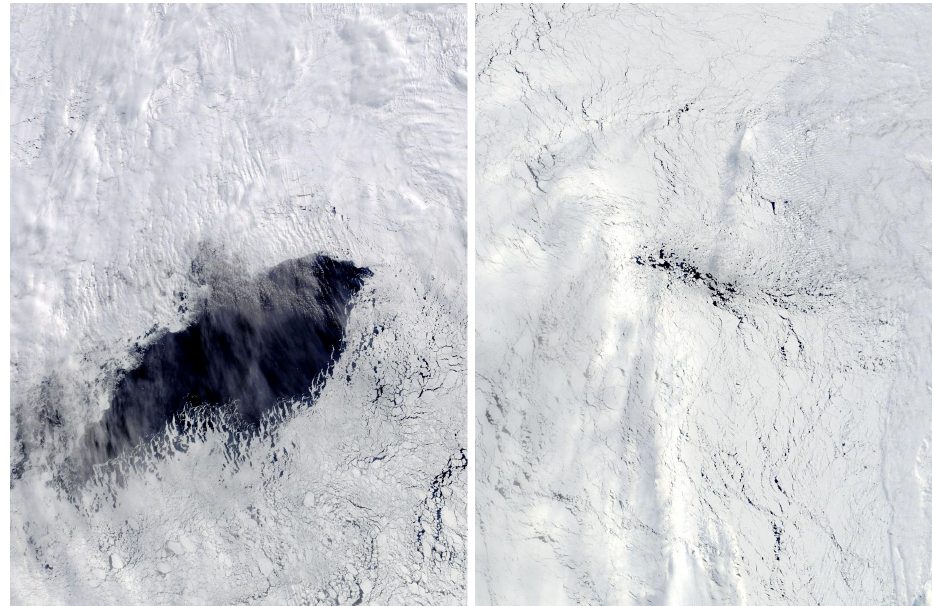
Figure A2. Left: MODIS image of the Weddell Sea polynya (25 September 2017). Right: MODIS image of the sea ice anomaly of 2018 (8 September 2018). The area viewed in both images is the same and is chosen by assigning the bottom left corner and top right corner to chosen coordinates upon selection: 67 ◦ S, 1 ◦ E and 61 ◦ S, 8 ◦ W, respectively (images from NASA Worldview, https://worldview.earthdata. nasa.gov/, last access: 25 April